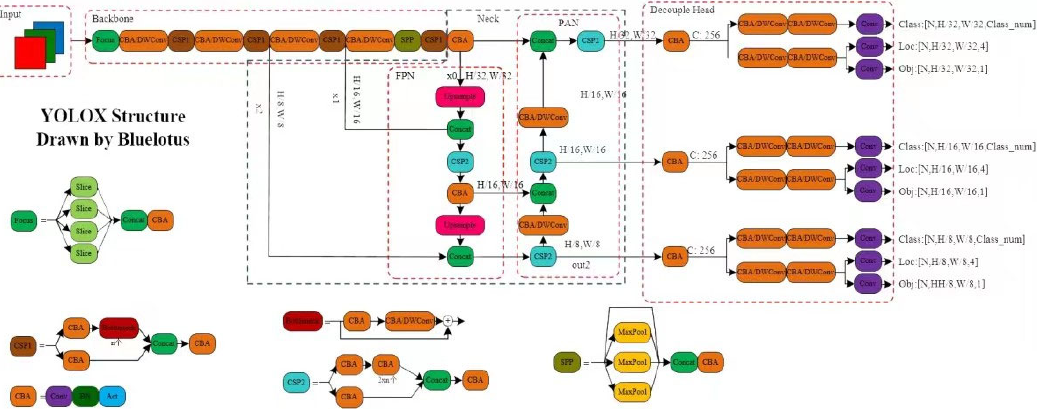
Figure 3. Structural framework of the YOLOX algorithm.